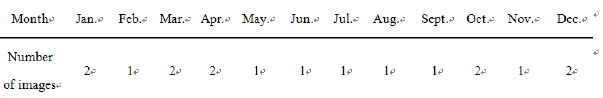
Fig.1 Study area for testing the LTSM algorithm Table 1 Frequency by month of all available Landsat data for the study area at Path 122 Row 35,